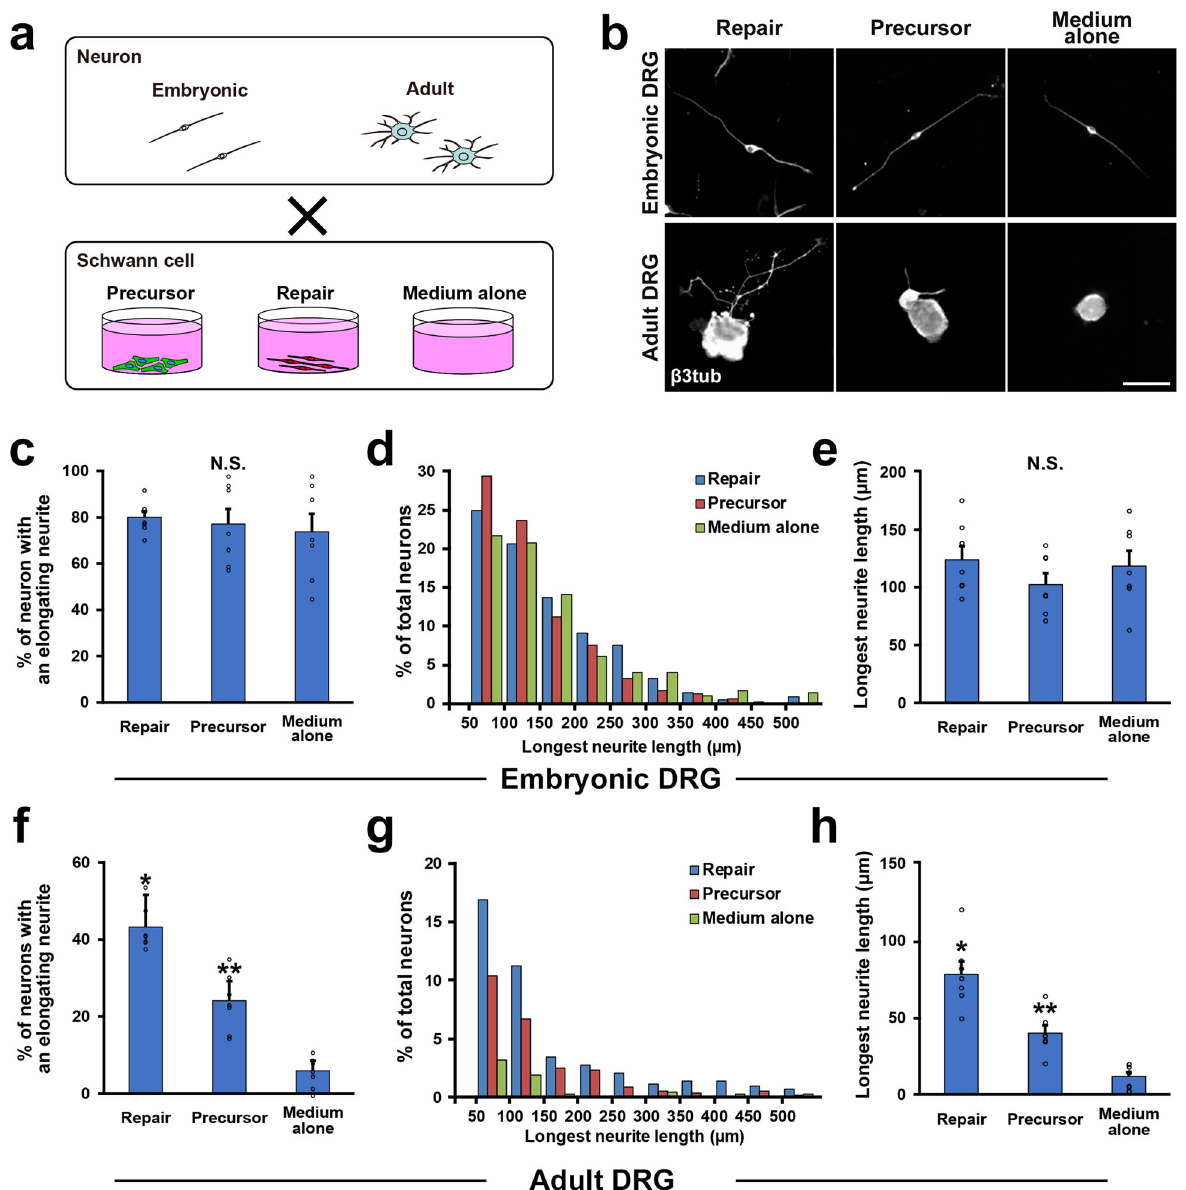
Fig. 5 Enhancement of neurite outgrowth of DRG neurons by co-cultured SCs. a Schematic diagram of co-culture of DRG neurons and SCs. b Representative images of neurite outgrowth of DRG neurons in each condition. Immunolabeling with β 3 tubulin depicted neurite elongation. Upper images are embryonic DRG neurons and neurite outgrowth of all three groups is comparable in length. Lower images are adult DRG neurons, showing a neuron co-cultured with RSCs elongated its neurite longer compared to neurons in other conditions. Scale bar, 50 μ m. c Quanti fi cation of % of elongating embryonic DRG neurons. No statistical difference was detected among groups. Seven samples per group. At least 50 neurons were calculated in each sample. d Percentage of embryonic DRG neurons with the longest elongating neurite in the categories shown. There is no apparent distribution pattern among groups. e Quanti fi cation of the longest neurite of embryonic DRG neurons. There is no statistical difference among groups, demonstrating that the presence of co-cultured SCs does not affect neurite outgrowth of embryonic DRG neurons. f Quanti fi cation of % of elongating adult DRG neurons. RSCs stimulated neurite outgrowth of adult DRG neurons signi fi cantly more than SCPs, and the next is SCPs compared to the medium alone. Seven samples per group. At least 50 neurons were calculated in each sample. g Percentage of adult DRG neurons with the longest elongating neurite in the categories shown. h Quanti fi cation of the longest neurite of adult DRG neurons. RSCs promoted the length of neurite outgrowth of adult DRG neurons most among groups and the next is SCPs compared to medium alone. *, ** P < 0.05 vs. others. One-way ANOVA with the Tukey – Kramer test. Error bars represent the